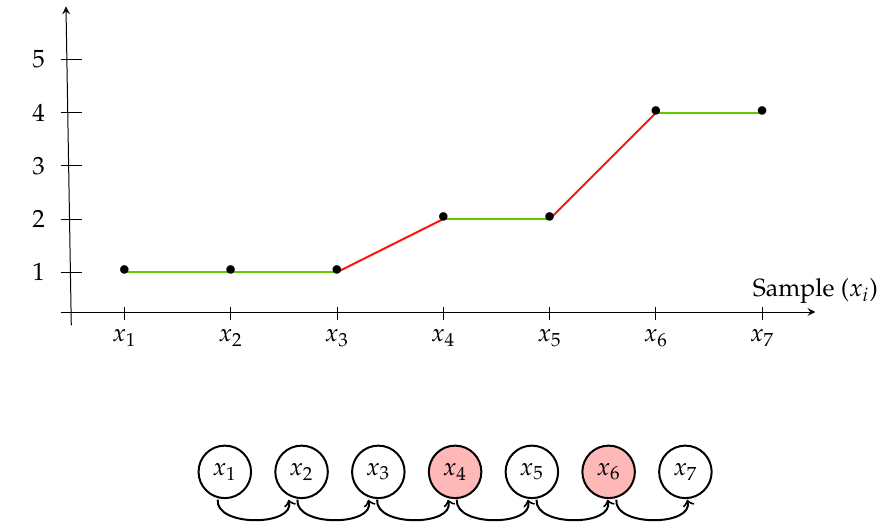
Figure 7. Example of scores in a differential detection test describing no detection of a stimulus (in green) and the detection of a stimulus (in red) at samples x 4 and x 6 and where a threshold (cid:101) = 1 is